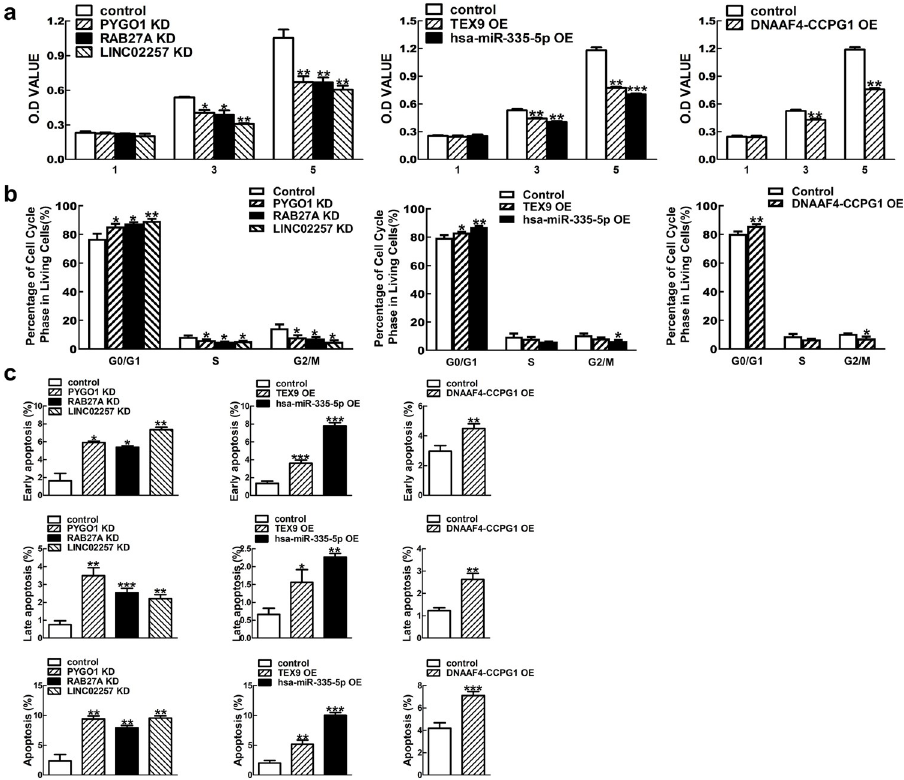
Fig 6. Loss-of-function and gain-of-function assays inhibited cell proliferation, induced cell cycle arrest at G0/G1 phase and promoted cell apoptosis. Knockdown of PYGO1, RAB27A, LINC02257 and overexpression of TEX9, hsa- miR-335-5p, DNAAF4-CCPG1 inhibited KFs proliferation after culture for 3 and 5 days (A), arrested cell cycle at G0/ G1 phase after culture for 4 days (B) and promoted early, late and total apoptosis of KFs after culture for 4 days (C). Each assay was repeated in at least 3 independent cell samples. ( � P < 0.05, �� P < 0.01, ��� P < 0.001).